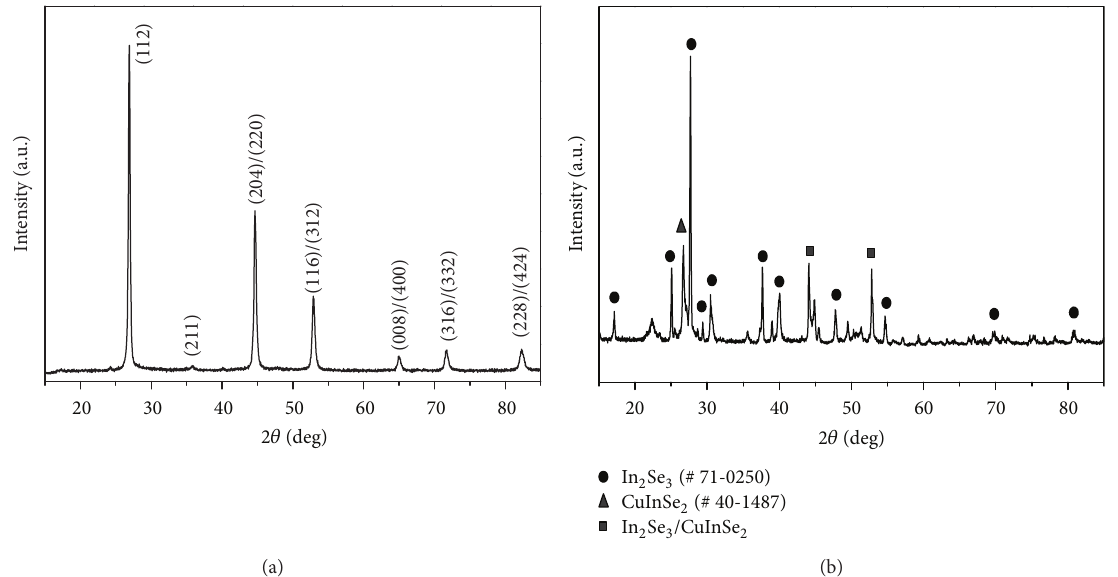
Figure 2: XRD patterns obtained from the annealed thin film made by (a) CuSe and InSe and (b) Cu 2 Se and In 2 Se 3 .